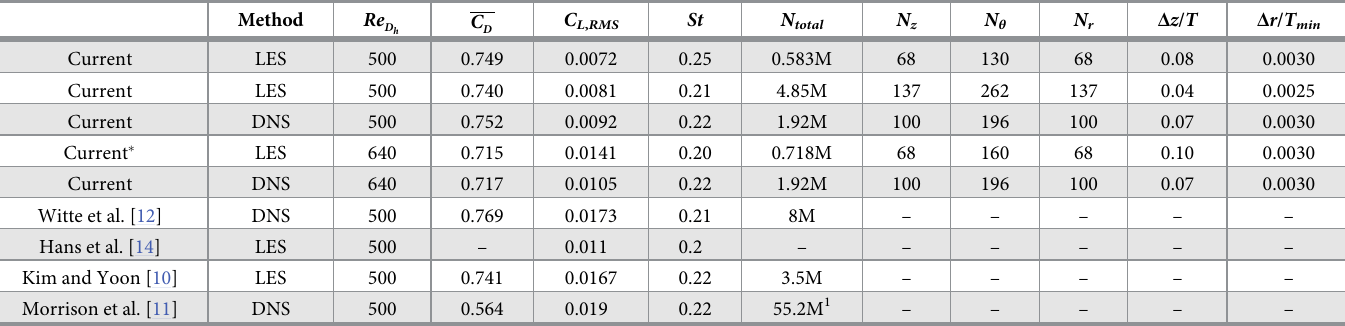
Table 3. Comparison of mesh variations with previous literature.